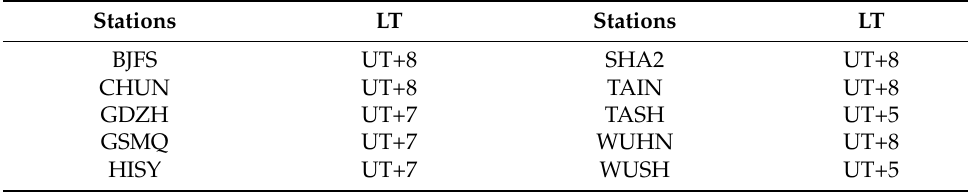
Table 2. UT to LT conversion for 24 GNSS stations from the